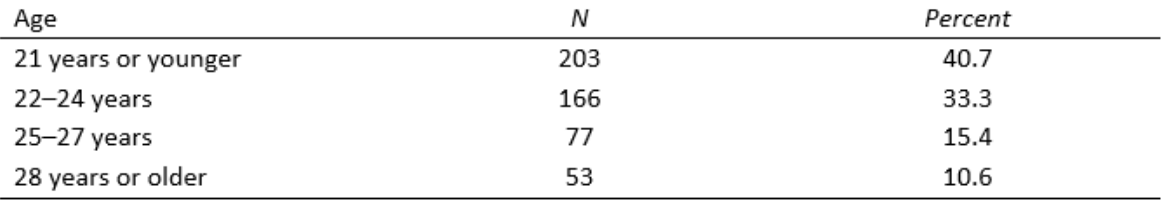
Table 2 . Age distribution of students participating in the study (N=499)